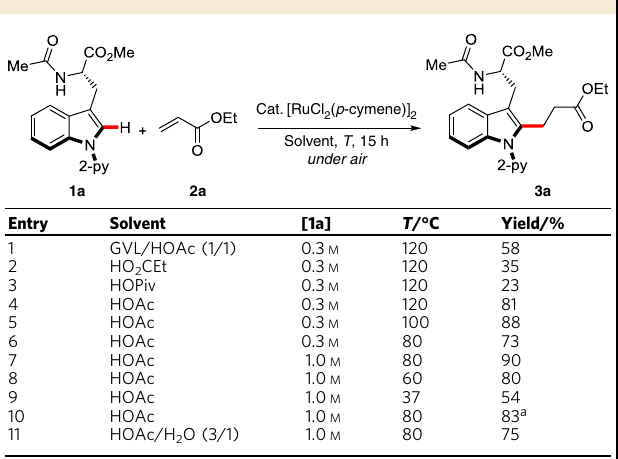
Key aspects of C – H alkylation optimization, highlighting acid-enabled C – H activation. Reaction conditions: 1a (0.15mmol), 2a (0.45mmol), [RuCl 2 ( p -cymene)] 2 (10mol %), solvent, 15h a [RuCl 2 ( p -cymene)] 2 (5.0mol %). 2-py: 2-pyridyl